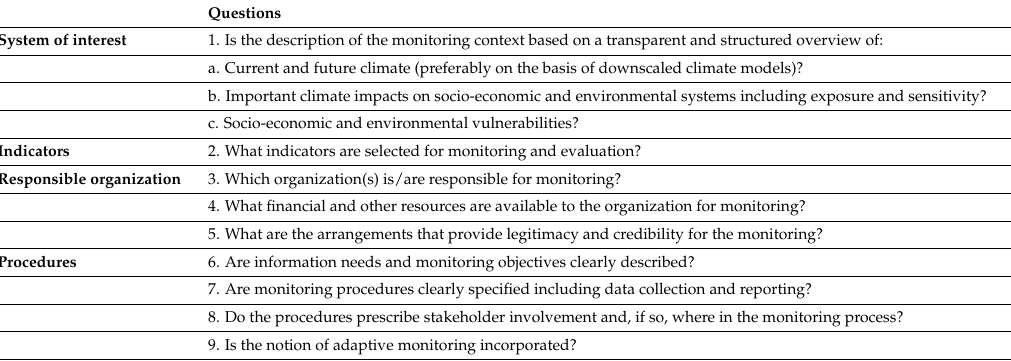
Table 1. Questions for the design of a monitoring program from Klostermann et al. (2018).